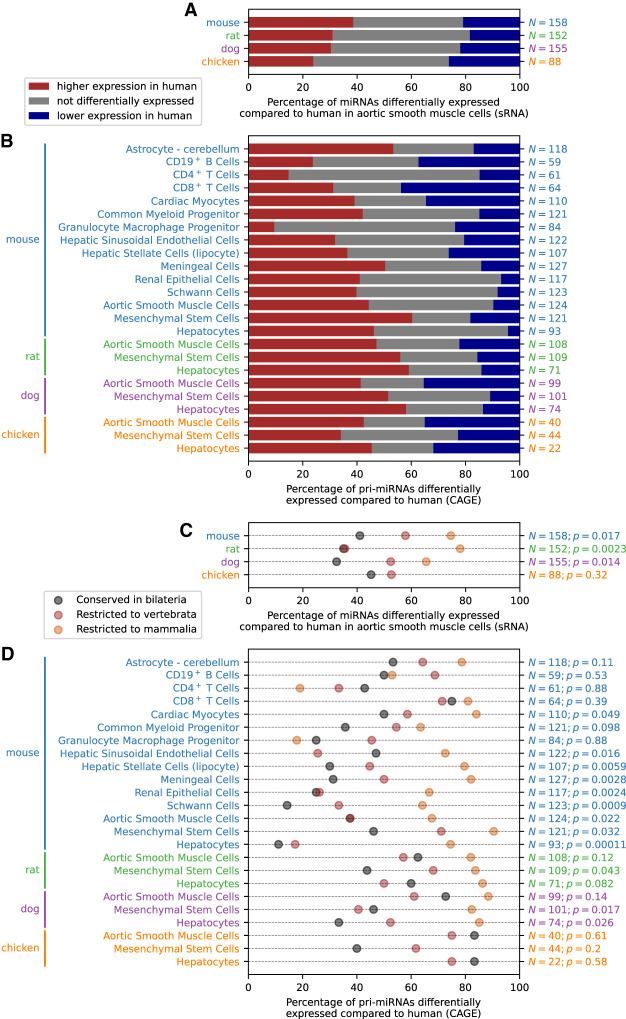
Differential miRNA expression analysis. (A) Differential expression analysis of miRNAs using FANTOM5 sRNA sequencing data in aortic smooth muscle cells in human compared to mouse, rat, dog, or chicken. The red and blue bars correspond to the percentage of expressed orthologous miRNAs with significantly (Benjamini–Hochberg corrected P < 0.1) higher and lower expression, respectively, in human compared to mouse, rat, dog, or chicken. The number N of expressed orthologous miRNAs in each comparison is shown on the right. (B) Differential expression analysis of miRNAs in human compared to mouse, rat, dog, and chicken; using CAGE expression of the pri-miRNA as a proxy for the expression level of the mature miRNA. The red and blue bars correspond to the percentage of expressed orthologous miRNAs with significantly (Benjamini–Hochberg corrected P < 0.1) higher and lower expression, respectively, in human compared to mouse, rat, dog, or chicken. The number N of expressed orthologous miRNAs in each comparison is shown on the right. (C) Percentage of miRNAs differentially expressed in each comparison, separately based on the evolutionary age of each miRNA. The one-sided P-value of a Poisson regression model against the evolutionary age category is shown on the right, together with the number N of expressed orthologous miRNAs in each comparison. (D) Percentage of miRNAs differentially expressed in each comparison, separately based on the evolutionary age of each miRNA; using CAGE expression of the pri-miRNA as a proxy for the expression level of the mature miRNA. The one-sided P-value of a Poisson regression model against the evolutionary age category is shown on the right, together with the number N of expressed orthologous miRNAs in each comparison.